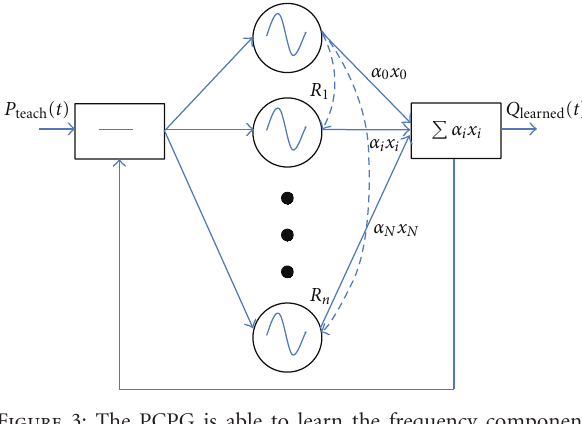
Figure 3: The PCPG is able to learn the frequency components of a periodic signal as well as the various phases and magnitudes. One major interest of PCPGs is the possibility to modify a learned pattern in amplitude or frequency in a smooth way. This figure is adapted from Righetti et al.